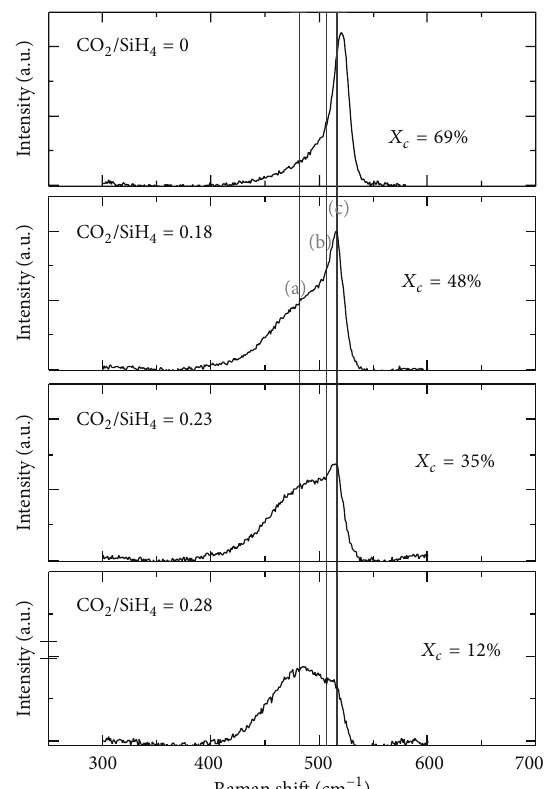
Figure 1: Raman spectra of n 𝜇 c-SiO:H films deposited with differ- ent CO 2 /SiH 2